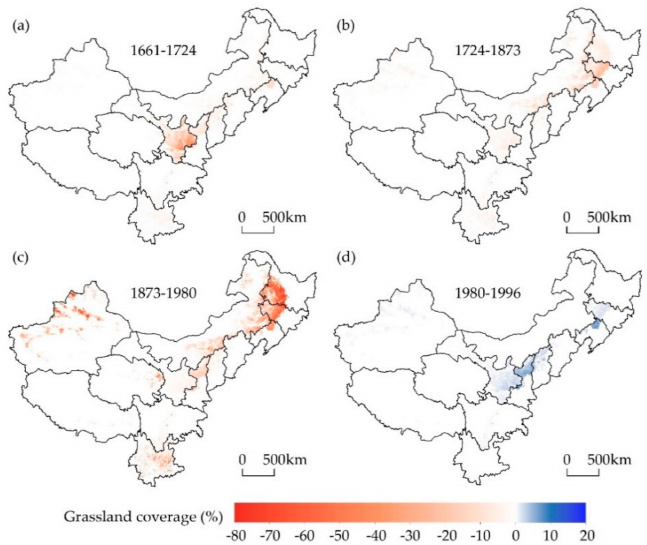
Figure 7. Maps showing net changes in grassland cover across western China for time periods between ( a ) 1661 and 1724; ( b ) 1724 and 1873; ( c ) 1873 and 1980; and ( d ) 1980 and